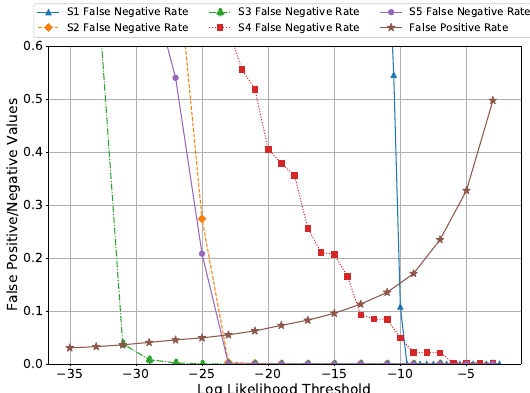
model in identifying malicious requests over the long